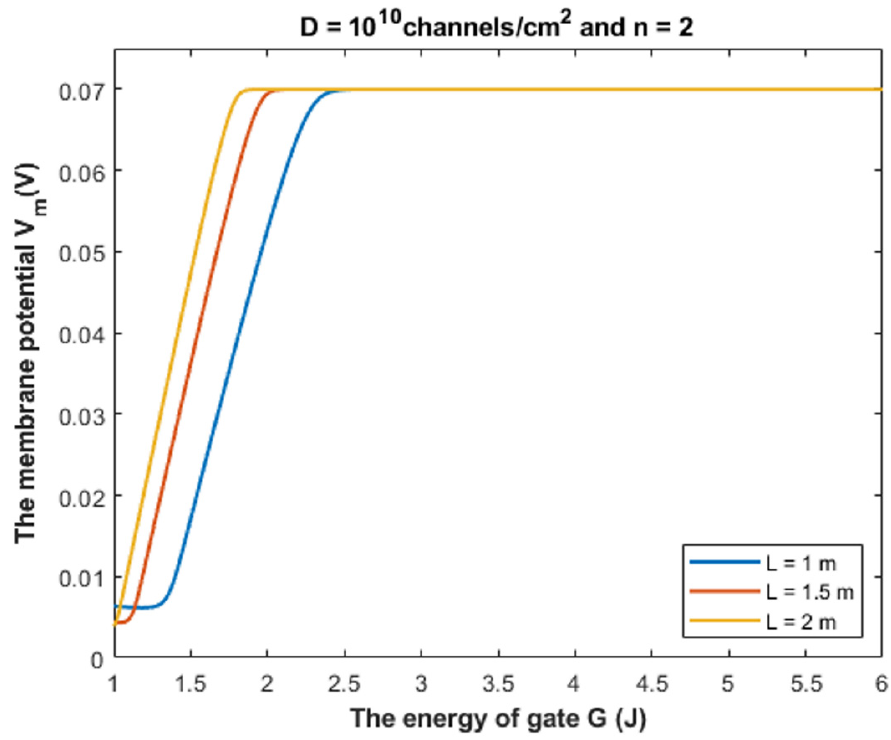
Figure 14. The figure represents the influence of the energy of gate G on the resting membrane potential according to different values of gate length and according to the setting values above the figure. The observed depolarization effect is due to quantum tunneling of chloride ions through GABA receptors.